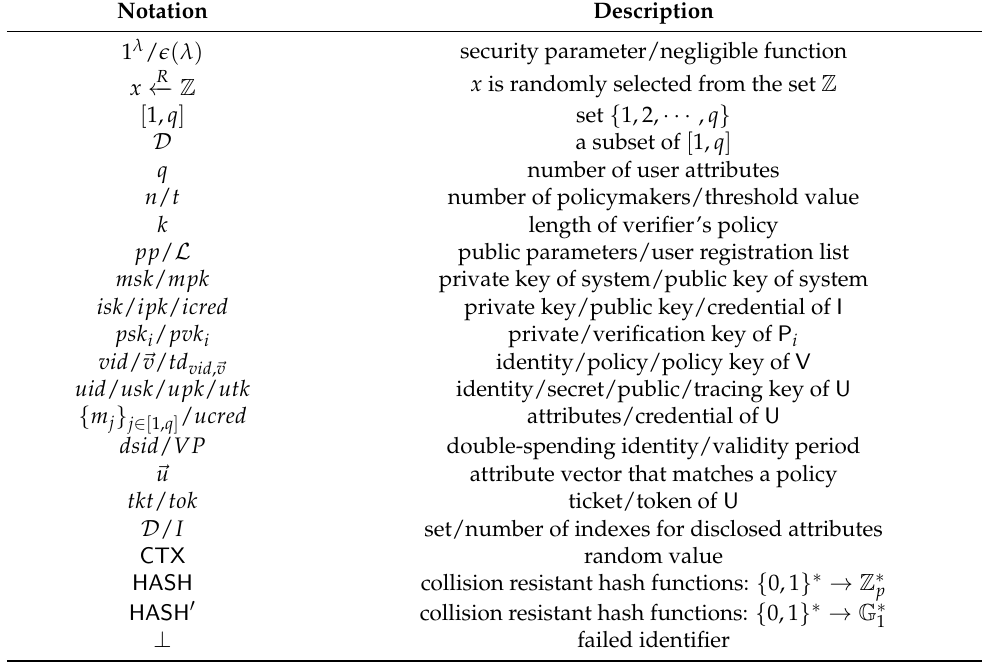
Table 3. Summary of